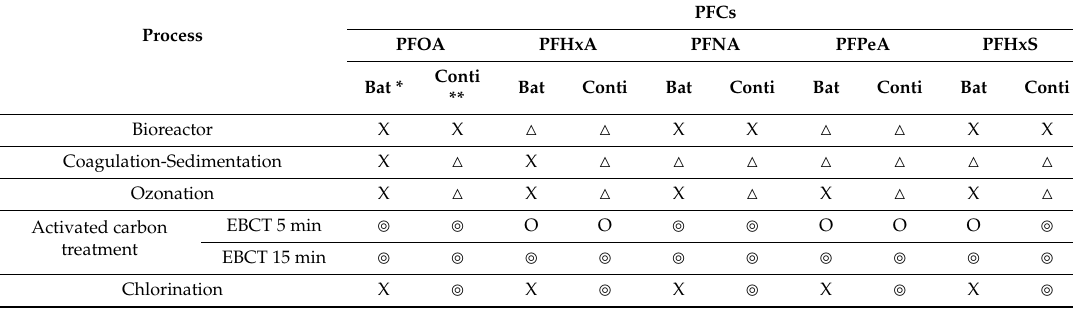
Table 3. Summary of PFCs applicability by various